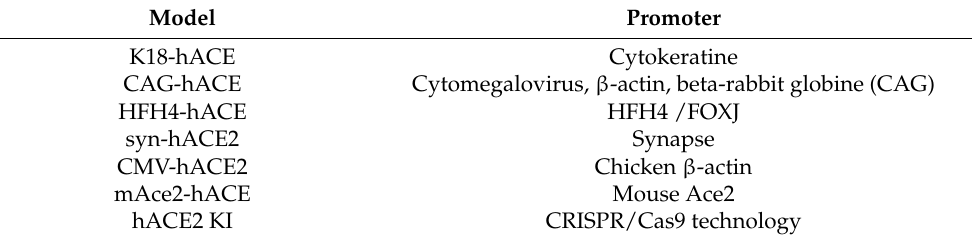
Table 1. Promoter regulators in different hACE2 mouse